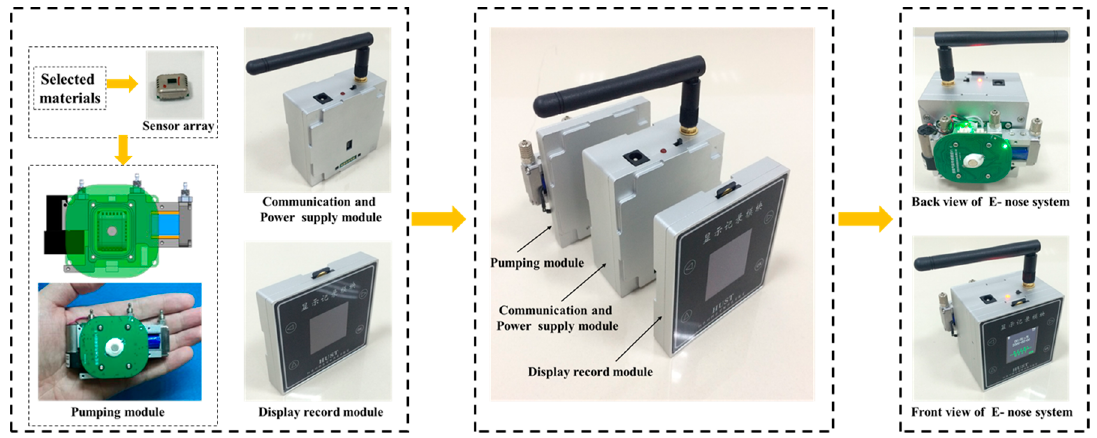
Figure 8. The structure of the handheld wireless E-nose system.